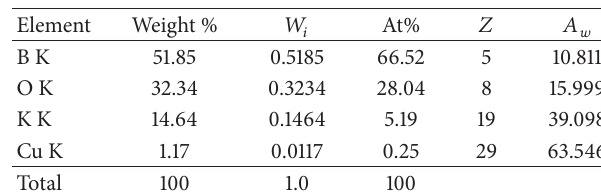
Table 2: Identification of the compositions and concentrations of Cu-doped potassium borate glass by